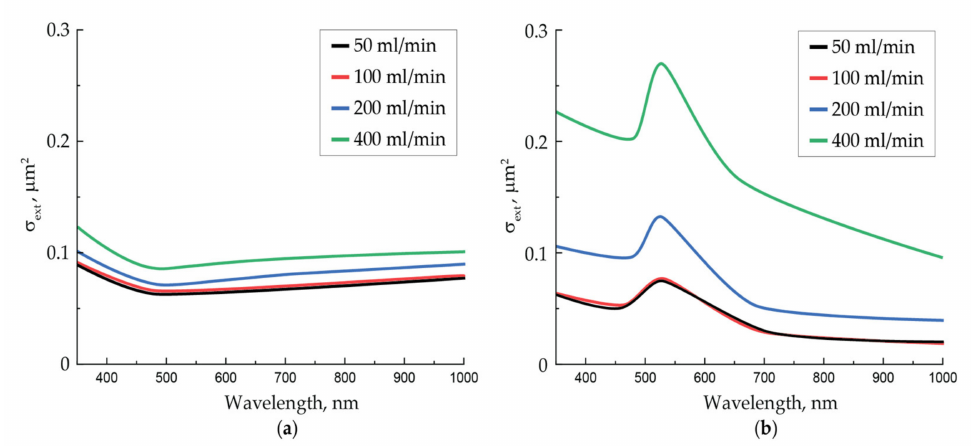
Figure 3. Extinction cross-section spectra of a single NP averaged over the flow of ( a ) initial gold NPs agglomerates and ( b ) thermally modified spherical NPs obtained at different gas flow